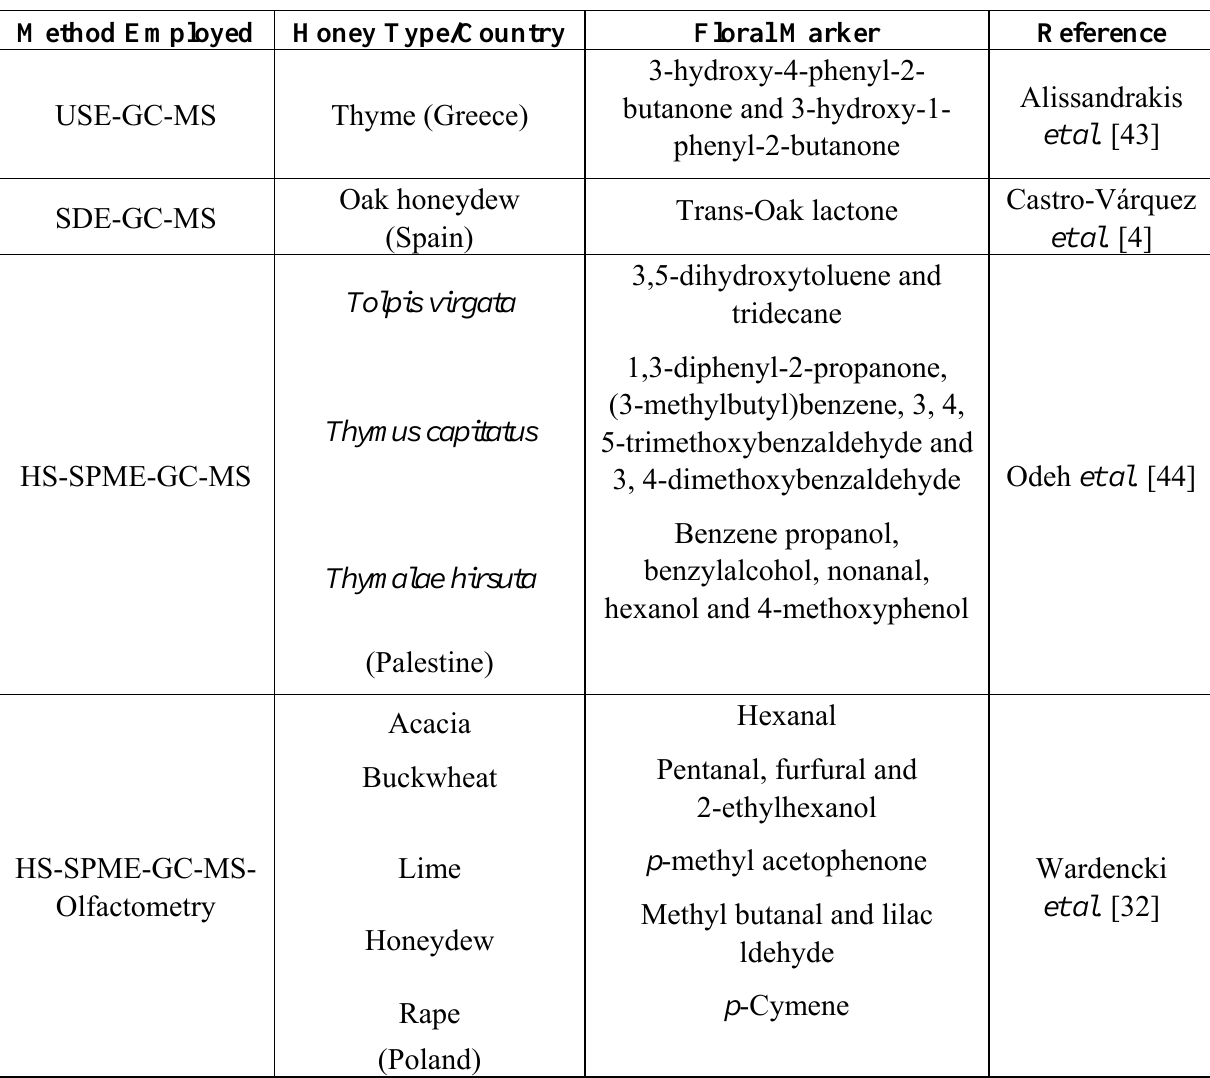
Table 1. Specific floral markers used to determine the botanical origin of particular honey